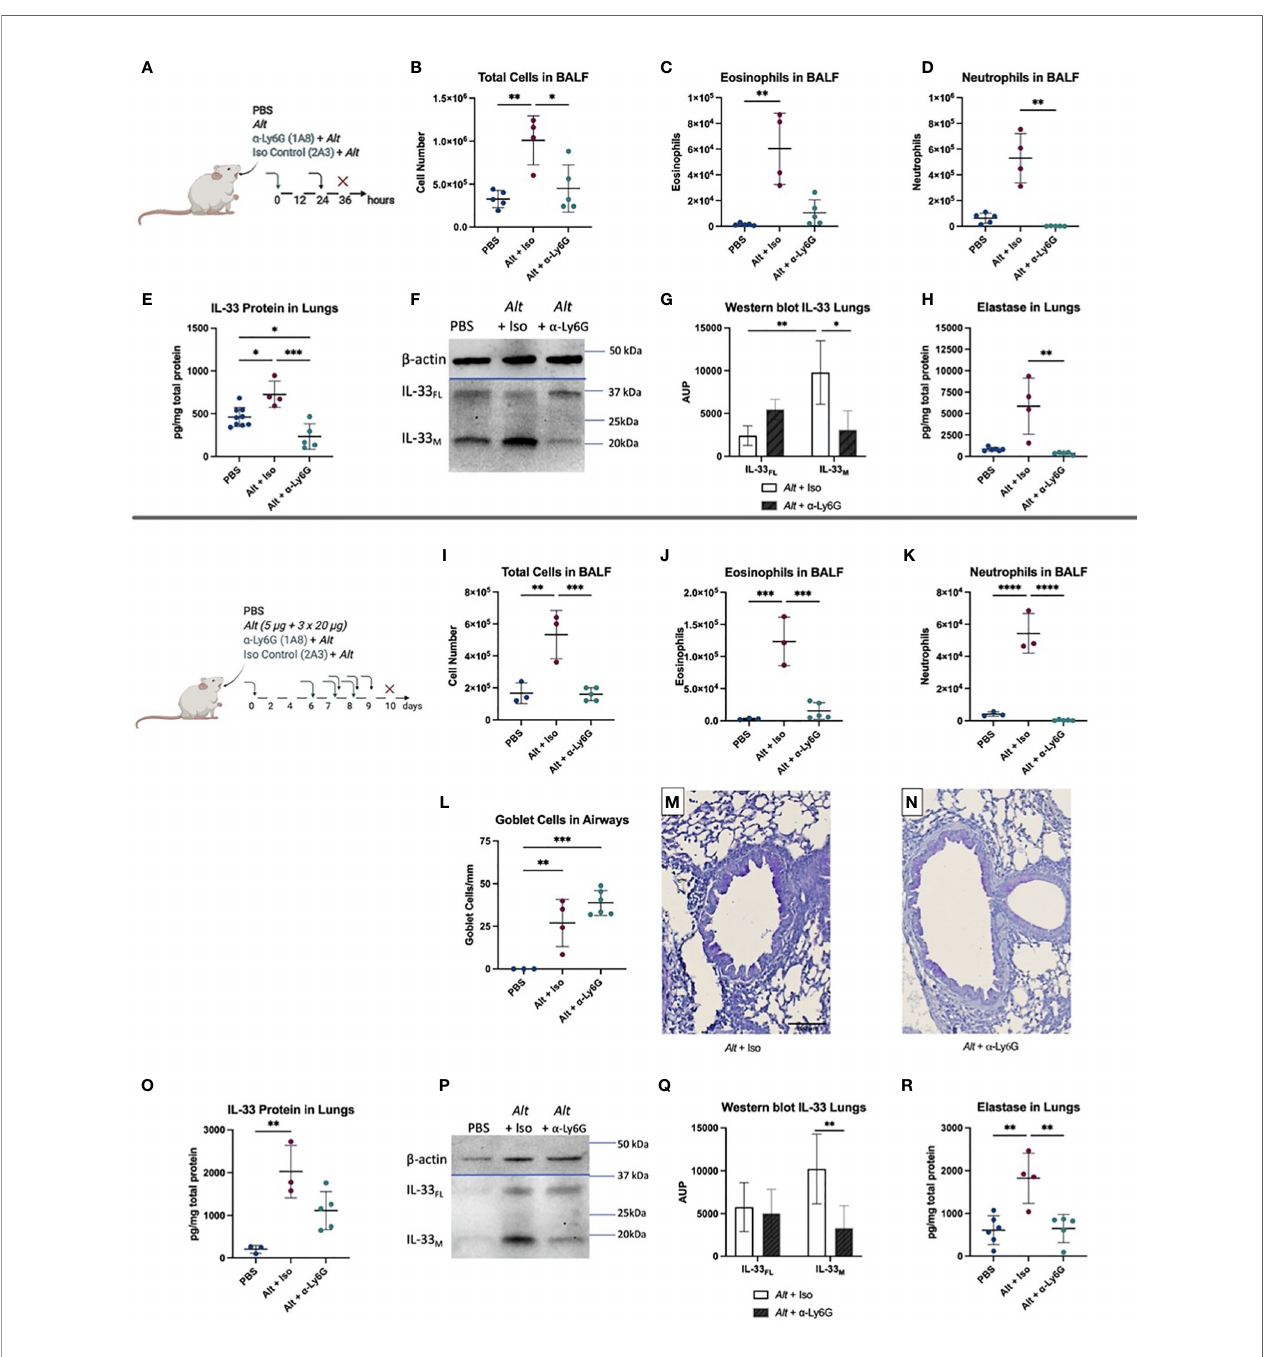
FIGURE 3 | BALB/c were given one i.p. injection of 100 µg anti-Ly6G antibody or IgG2a isotype control (Iso). After 24 hours, they received one i.t. application of 20 µg Alternaria alternata ( Alt) extract or PBS. Twelve hours later the mice were euthanized, and samples were collected (A) . The total cell count (B) , eosinophils (C) , neutrophils (D) in BALF determined by fl ow cytometry. IL-33 protein levels (E) and one representative western blot to detect full-length IL-33 (IL-33 FL ) and cleaved forms (IL-33 M ) (F) with quanti fi cation of area under the peak (A.U.P.) (G) are shown. Elastase protein levels, measured by Luminex, in the lung are presented (H) . Next, BALB/c mice were fi rst sensitized with one i.t. application of 5 µg Alt extract or PBS. On days 7, 8 and 9 the mice got challenged by i.t. applications of 20